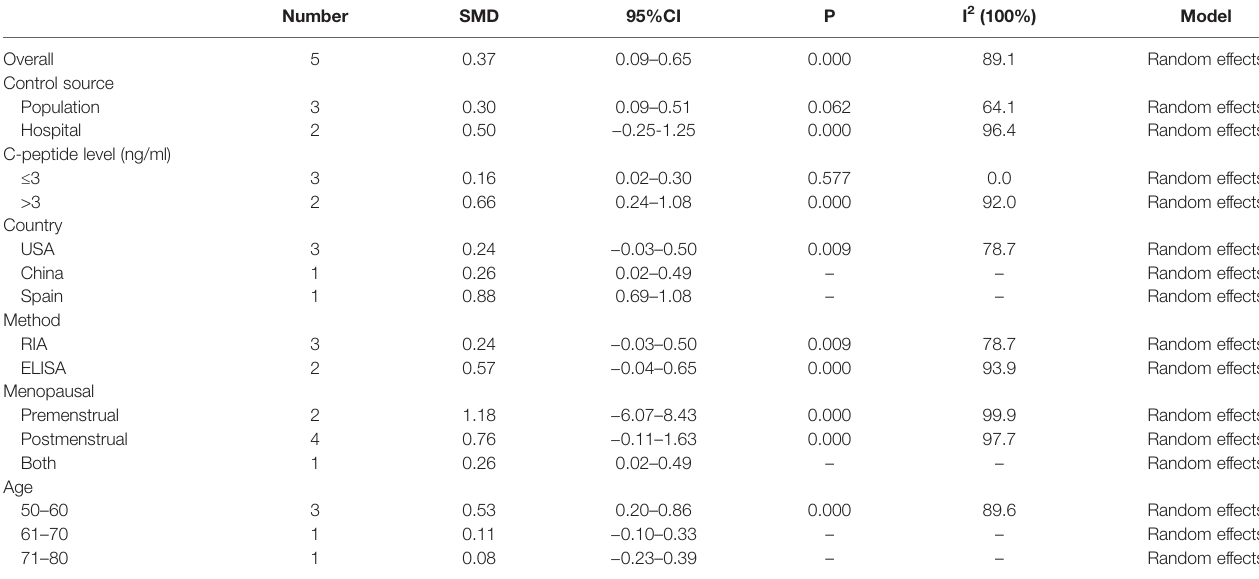
TABLE 3 | The pooled and subgroup results of the serum C-peptide levels in breast cancer patients compared with the control